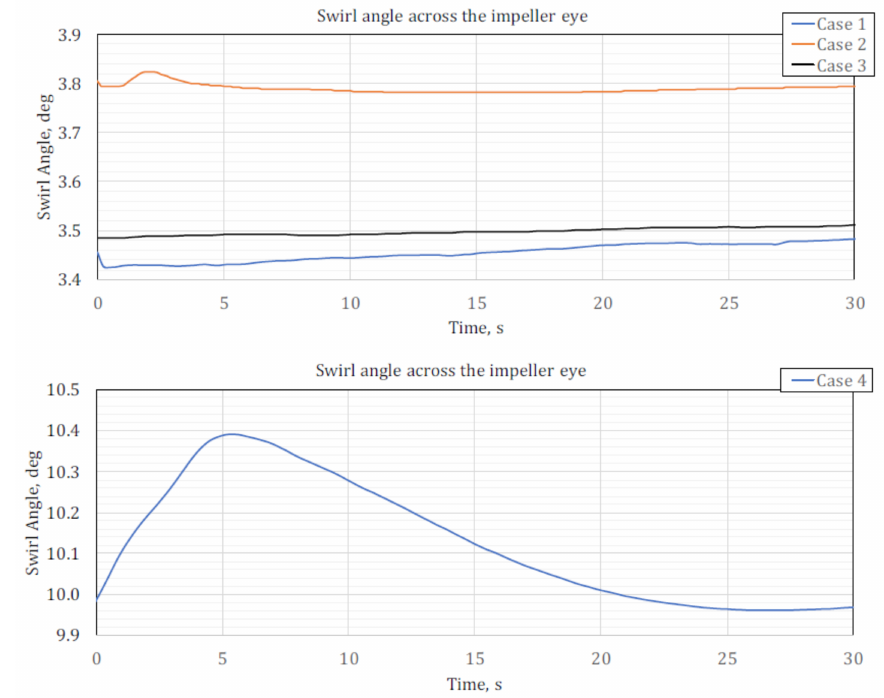
Figure 15. Swirl angle across the impeller.